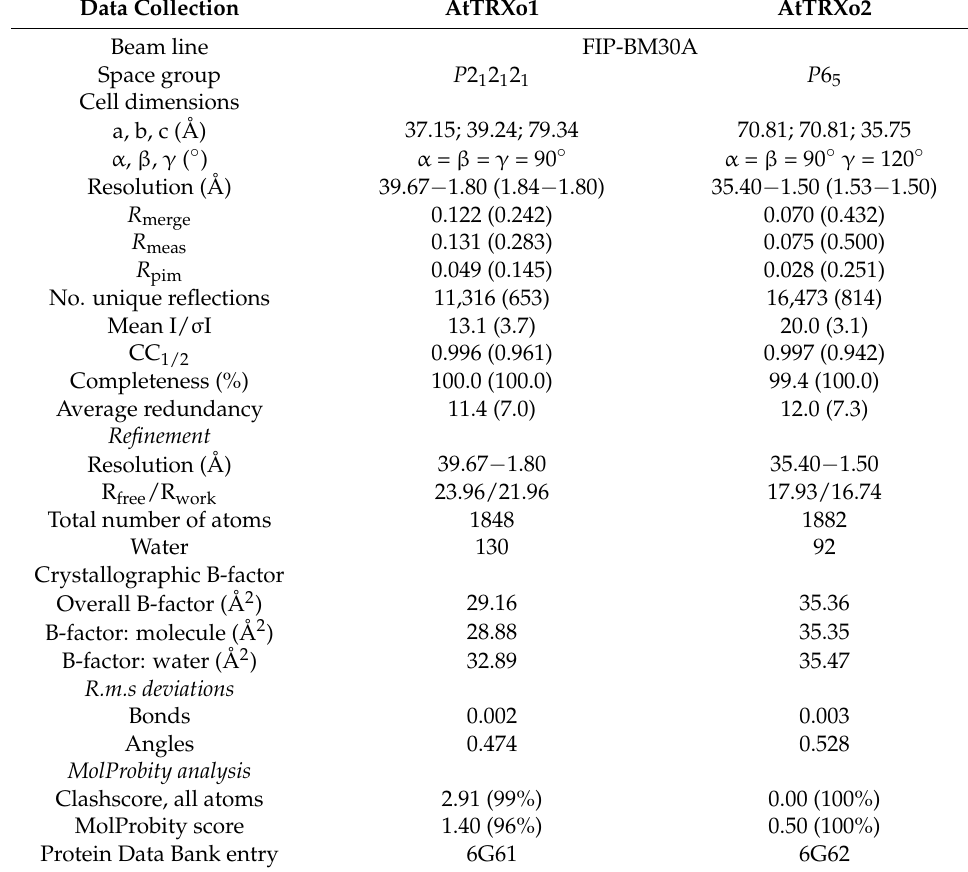
Table 1. Data collection and refinement